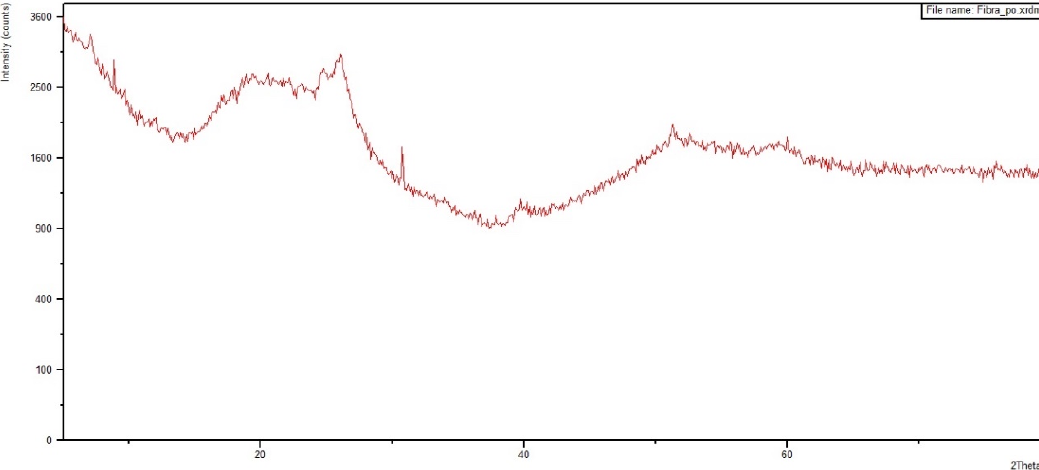
Figure 12. Diffractogram of the 30 vol% ramie fabric-reinforced GO-incorporated epoxy composite in Figure 12. Di ff ractogram of the 30 vol % ramie fabric-reinforced GO-incorporated epoxy composite in the physical state of powder. the physical state of powder. Polymers 2020 , 12 , x